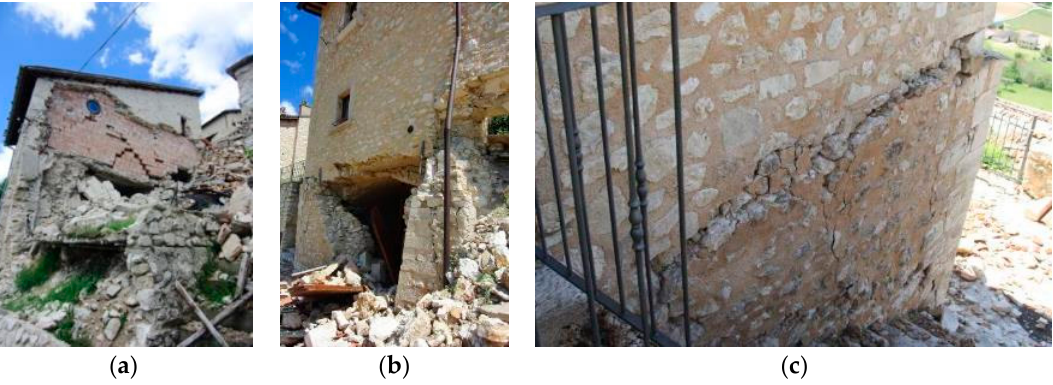
Figure 5. Example of differential retrofitting with reconstruction of the upper floors: ( a ) damage in the upper floors and collapse in the ground floor; and ( b , c ) no damage to the upper floor, but roto-translation above the partially collapsed ground floor.